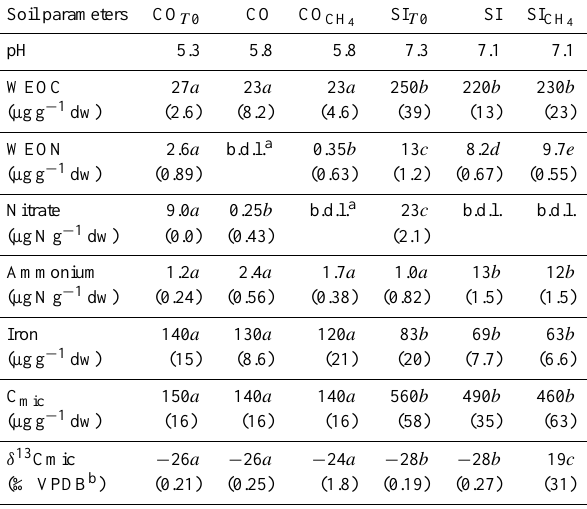
Table 1. Soil characteristics of SI and CO before the incubation experiment started (CO T 0 , SI T 0 ) and after major anaerobic experi- ment without (CO, SI) and with methane (CO CH ent parameters were measured: pH value (CaCl 2 ) , water extractable organic carbon (WEOC) and nitrogen (WEON), nitrate and am- monium concentrations, reducible iron [Fe(III)], microbial biomass (C mic ) and δ 13 C mic . Means and standard deviations, significant dif- ferences among treatments at p < 0 . 05 are indicated by different letters (a, b, c).